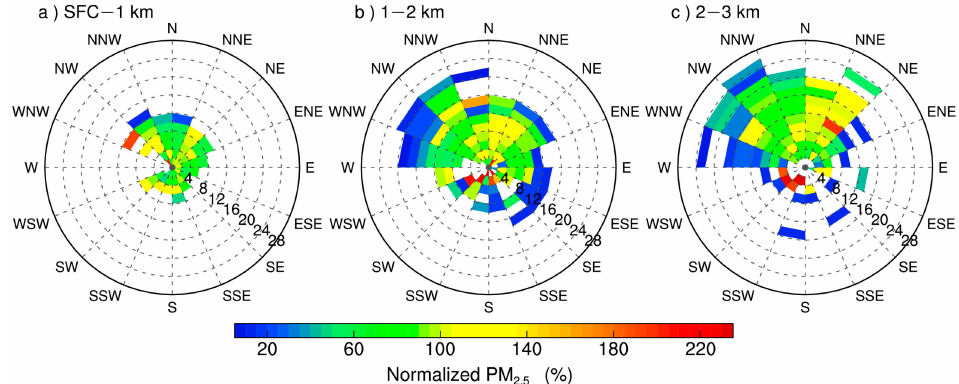
Figure 9. Bivariate polar plot of normalized PM 2.5 concentration (in percent) for the altitude ranges of ( a ) ground surface to 1 km (SFC–1km), ( b ) 1–2 km and ( c ) 2–3 km AGL during the period from December 1, 2018, to February 28, 2019. The wind directions are denoted by 16 compass direction: N, NNE, NE, ENE, E, ESE, SE, SSE, S, SSW, SW, WSW, W, WNW, NW, NNW. The radial axis